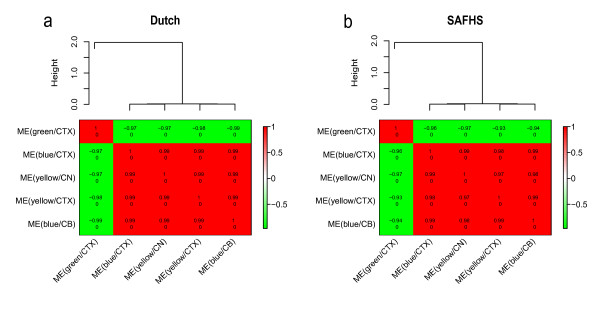
Relationships between the five preserved modules in the two blood data sets. The expression profiles of each preserved module were summarized by the respective module eigengene (defined as the first principal component). The correlations between the module eigengenes can be used to measure relationships between the modules (Langfelder and Horvath 2007). The hierarchical cluster tree shows the correlation relationships between the module eigengenes in the Dutch blood data (a) and the SAFHS blood data (b). The tables show the pairwise correlation coefficients (upper number) between the eigengenes and the correlation test p-values (lower number). The colors of the table entries color code the values of the correlations (green and red correspond to negative and positive correlations). Note that the four modules ME(blue/CTX), ME(yellow/CN), ME(yellow/CTX), and ME(blue/CB) were highly positively correlated with each other but negatively correlated with ME(green/CTX).